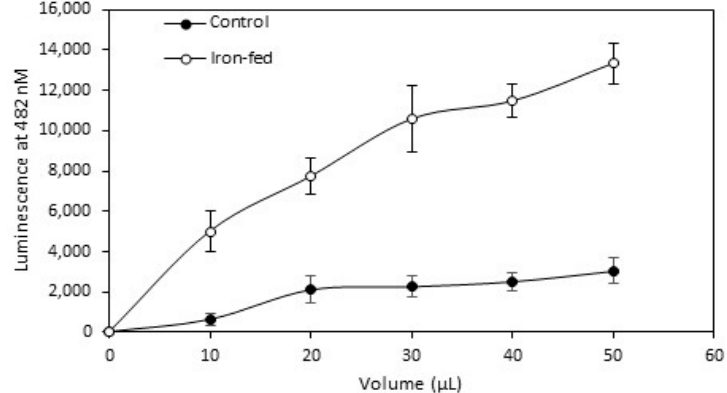
Figure 5. Reactive oxygen species (ROS). Control and iron-fed C8B4 microglia plated at equal density were exposed to serum free medium (without phenol red) for 24 h. Medium was collected and centrifuged and assessed for ROS using a luminescence assay with detection at 482 nm. Medium from iron-fed microglia showed significantly ( p < 0.05) higher levels of ROS than control microglia. Shown are the mean and S.E.M. of five separate experiments.